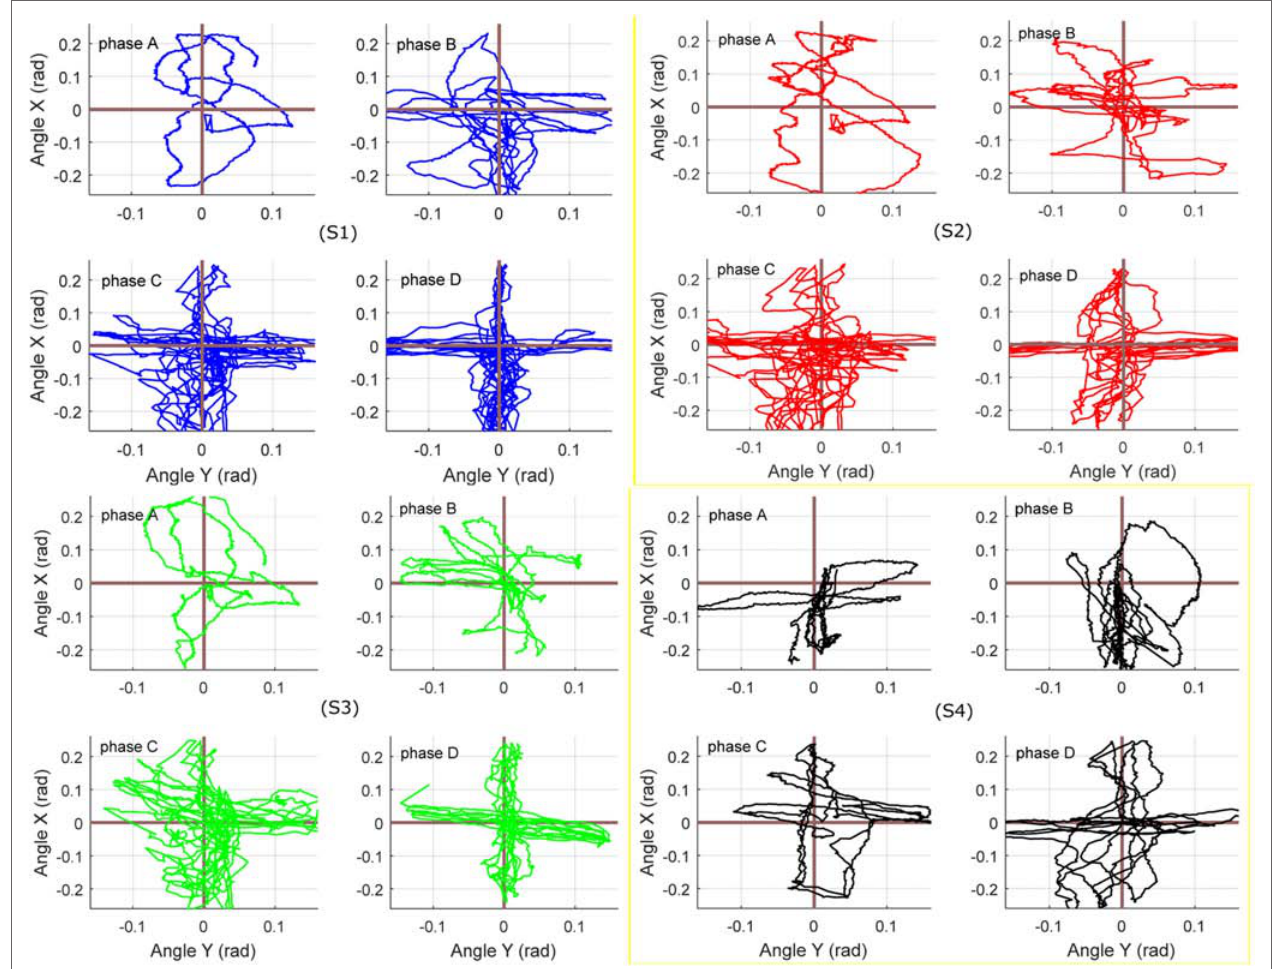
FIGURE 13 | Target reaching game results with hierarchical compliance control: the figures of four subjects from phases A to D indicate that the robot can cooperate to achieve better and better performance. Blue, red, green, and dark lines represent the results of S1, S2, S3, and S4,